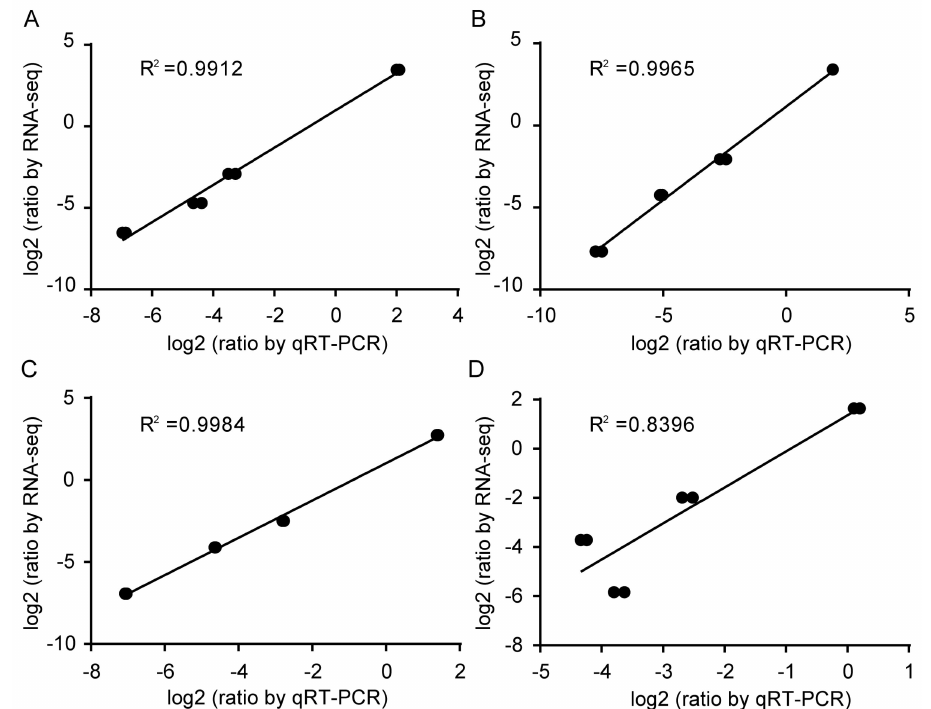
Figure 4. Correlation analysis between RT-qPCR results and the RNA-Seq data. X -axis represented log2(ratio by RT-qPCR), and equation 2 − ∆ Ct was applied to calculate the RT-qPCR relative expression level using selected target genes as the reference gene. Y -axis represented log2(ratio by RNA-Seq) ( p -value ≤ 0.01). Correlation analysis using ENDO4 and 18S rRNA was used as the internal controls for normalization of AUX22 and ERF17 in YZ1 ( A ), R15 ( B ), X33 ( C ), and X42 ( D ).